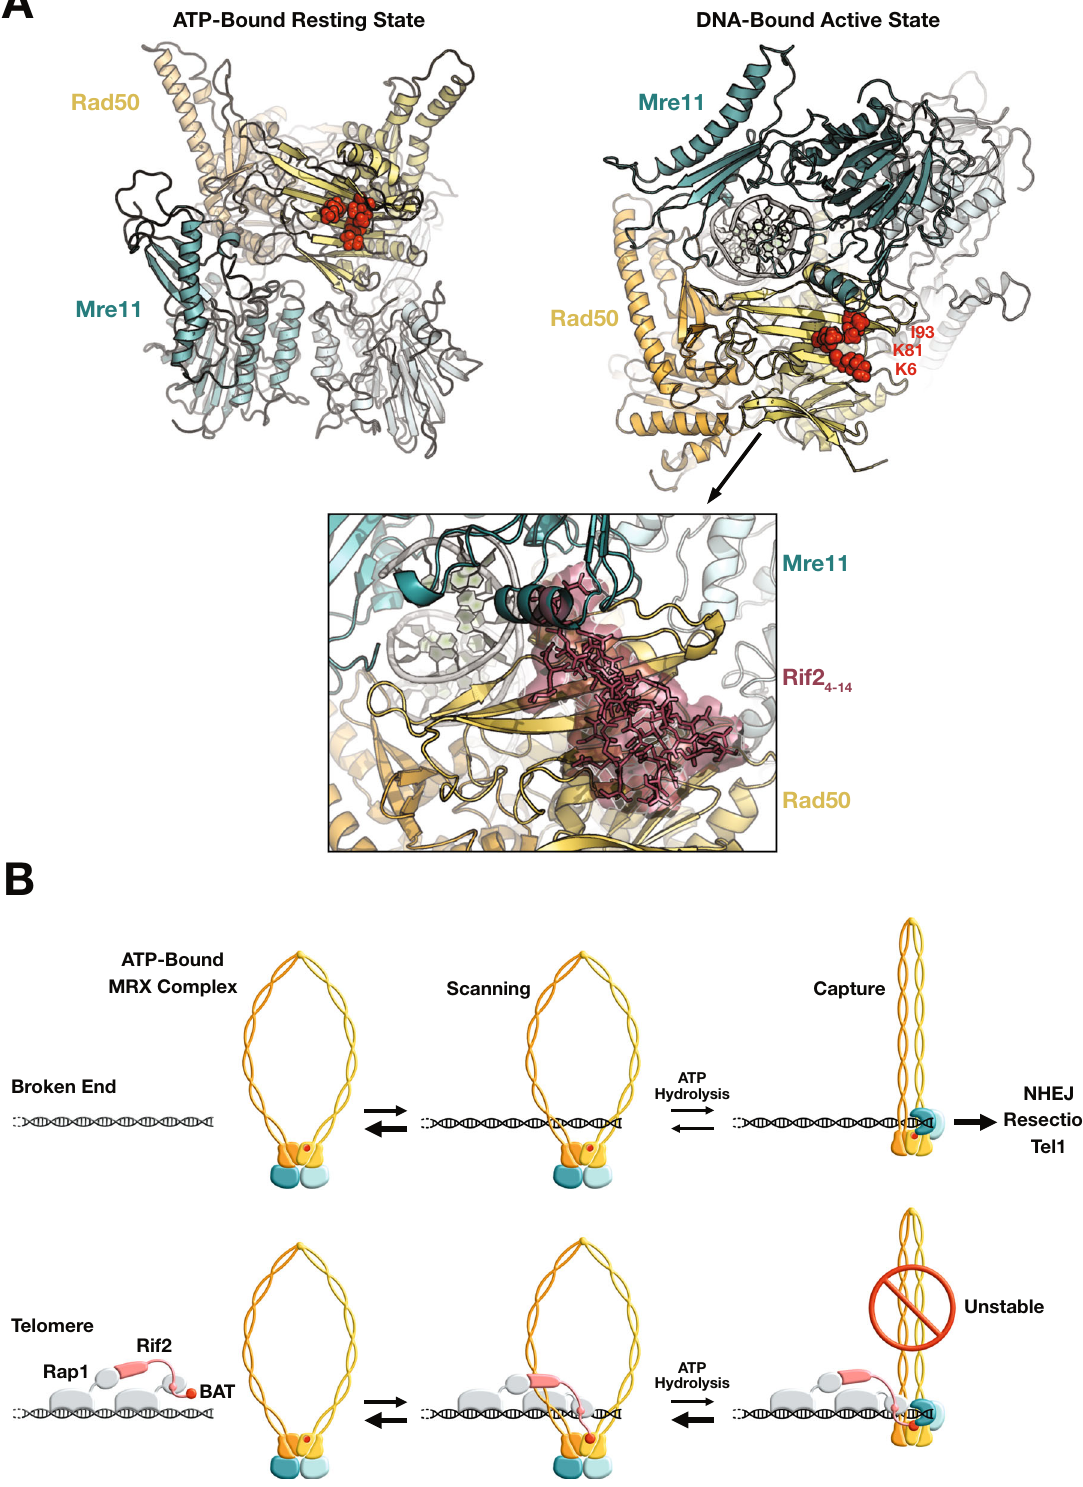
Fig. 7 Predicted impact of BAT binding on the Rad50 – Mre11 complex and model for MRX inhibition by Rif2 at telomeres. A Models of S. cerevisiae Rad50 – Mre11 complex in the ATP-bound resting state (left) and in the DNA-bound active state (right). Residues K6, K81 and I93 highlighted in red. Bottom panel: envelope of the BAT core peptide (Rif2 residues 4-14, in brown) belonging to the HADDOCK cluster 1 shown after superimposition of the Rad50 structures of the clusters on that of the DNA-bound Rad50 – Mre11 complex model. B Model for telomere protection by Rif2 at telomeres (Rad50 orange/yellow, Mre11 teal/light blue, Rap1 grey, Rif2 pink, BAT and BAT interacting region on Rad50 red). For simplicity, Xrs2 and other factors present at broken ends and at telomeres are not